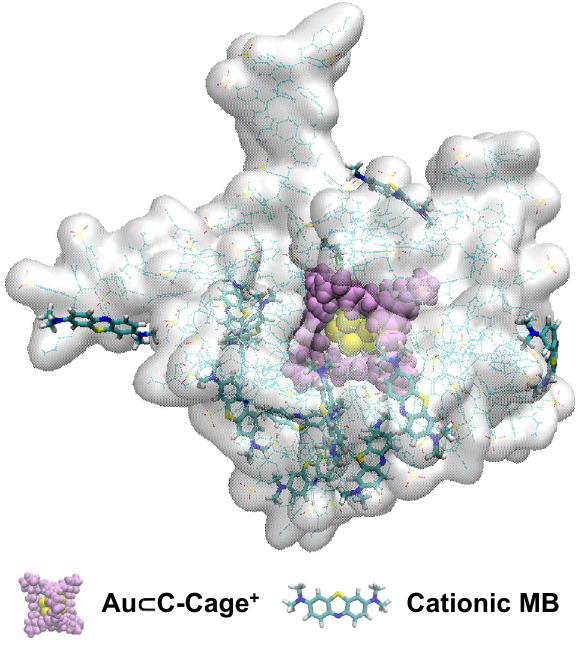
Fig. 4 A snapshot of MD simulation showing the [Au ⊂ C-Cage + ] ⊂ PoPIL − and cationic MB substrate. Yellow ball = Au cluster; Purple space fi lling mode = C-Cage + ; Green licorice mode = MB; White quick surface and green line mode = PoPIL − . The solvent and counterions are omitted for clarity. For details of MD simulations, please see Supplementary Computational